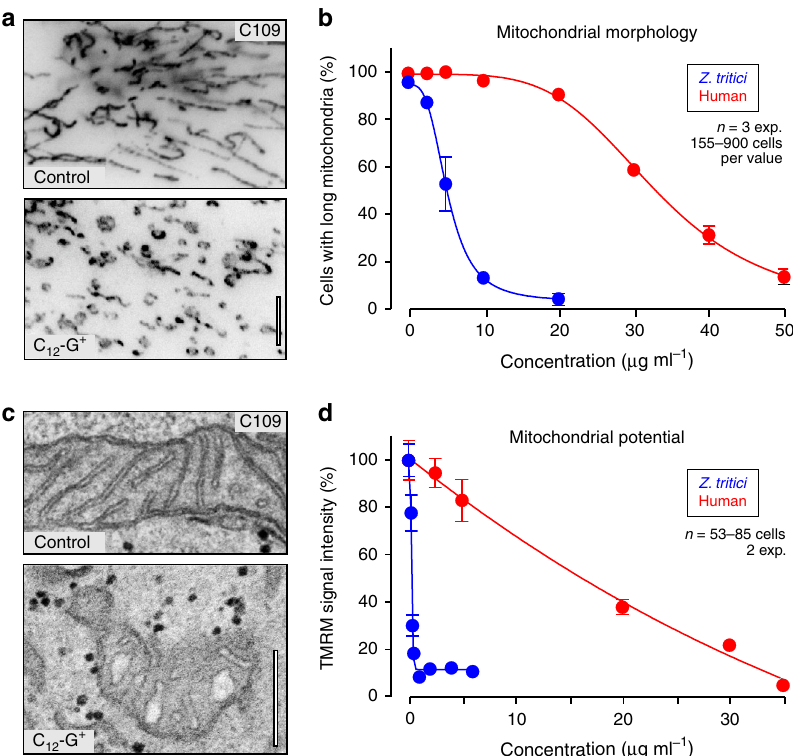
Fig. 3 Effect of C 12 -G + on mitochondria in human fi broblasts. a Mitochondria morphology in human skin fi broblasts (C109 cells), treated with the solvent (Control) and C 12 -G + . Mitochondria were labeled using an antibody against ATP synthase B. Scale bar = 5 µ m. b Sensitivity of mitochondria morphology to C 12 -G + in C109 cells (Human) and Z. tritici cells. See Table 1 for EC 50 values. c Ultrastructure of mitochondria in human fi broblasts, treated with the solvent (Control) and C 12 -G + . Note swollen cristae in C 12 -G + -treated C109 cells. Scale bar = 0.3 µ m. See also Supplementary Fig. 3a. d Sensitivity of mitochondrial potential to C 12 -G + in C109 cells (Human) and Z. tritici cells. See Table 1 for EC 50 values and also Supplementary Fig. 3b. Values ( b , d ) are shown as mean ± SEM; sample size n is indicated in each panel. Non-linear regression curve was calculated as dose-response inhibition (four parameters) in Prism5. See Supplementary Table 7 for experimental conditions. All source data are provided as a Source Data fi